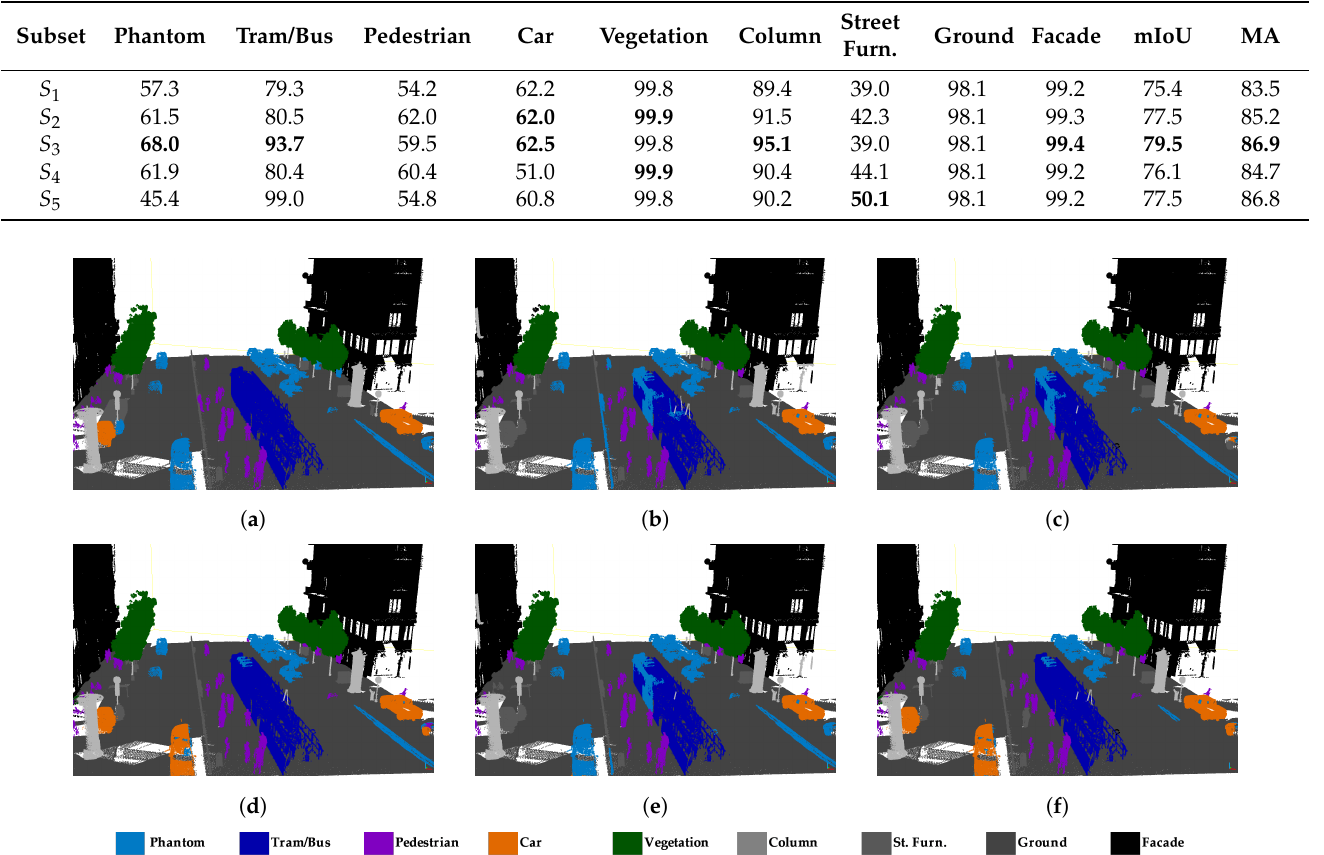
Figure 8. Qualitative results of the methods for SZTAKI-CityMLS with SPG. ( a ) Ground Truth; ( b ) S 1